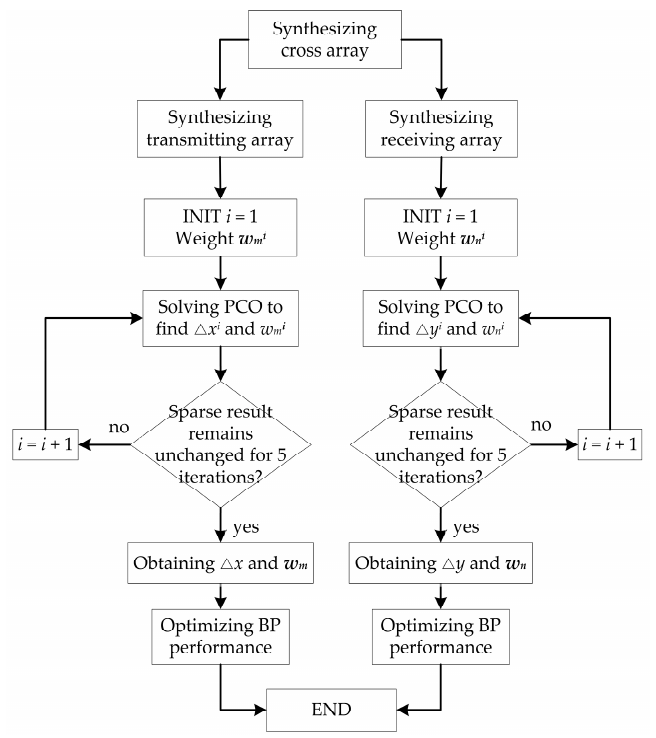
Figure 6. Flow diagram of a sparse cross array synthesis in near-field and far-field.